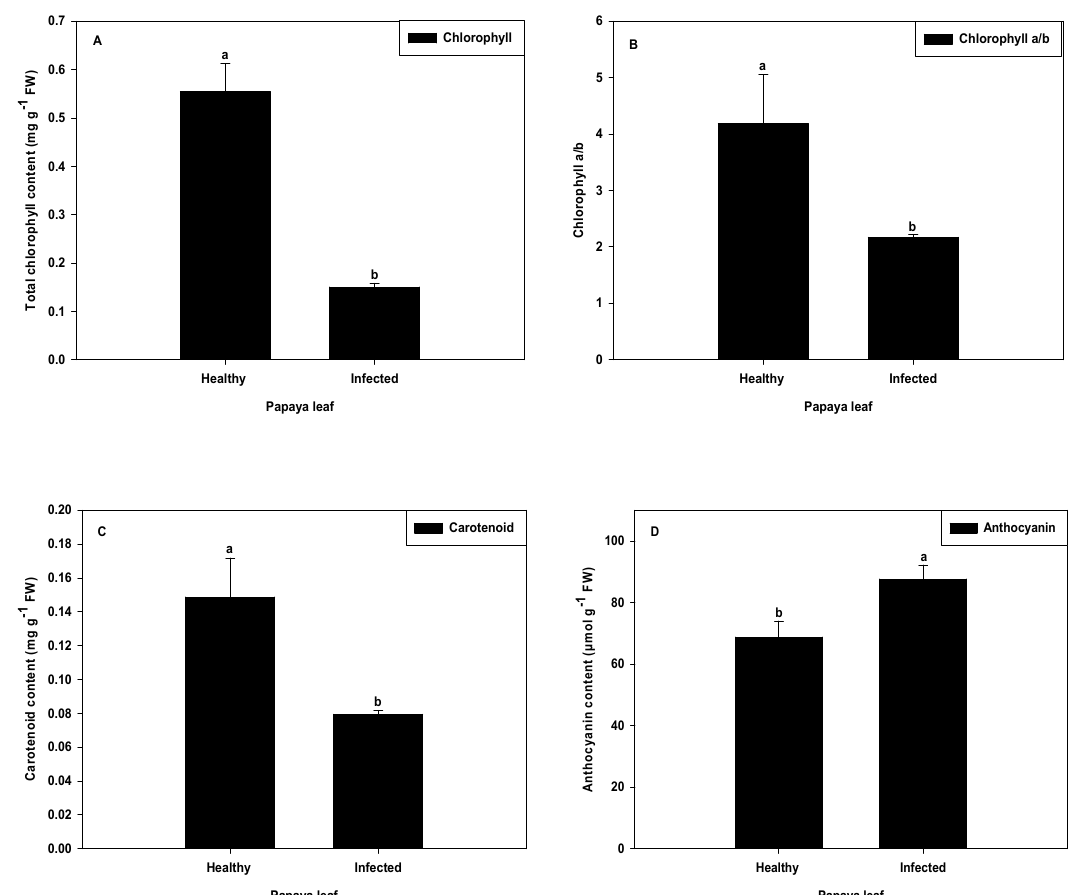
Figure 6. Effect of PaLCuV virus infection on ( A ) total chlorophyll content, ( B ) chlorophyll ratio, ( C ) carotenoid content, and ( D ) anthocyanin content. Error bars shown as the standard error of mean (SE) was computed by Sigma Plot 14, different letters above the error bars show significant differences at p ≤ 0.05.